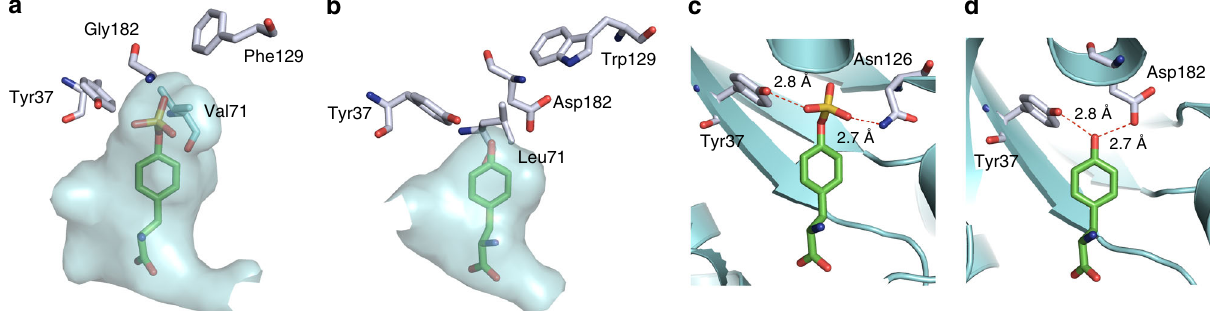
Fig. 3 Amino acid binding pocket of sTyrRS and wild-type Ec TyrRS. a – b Active site close-ups of the evolved sTyrRS ( a , PBD ID: 6WN2) and Ec TyrRS ( b , PDB ID: 1X8X). The active site surfaces are in cyan. Four residues included in library construction are labeled. c – d Recognition of ligands by sTyrRS ( c ) and the wild-type Ec TyrRS ( d ). Carbon atoms in ligands are shown in green. Carbon atoms in proteins are shown in silver. All oxygen atoms are in red, nitrogen atoms are in